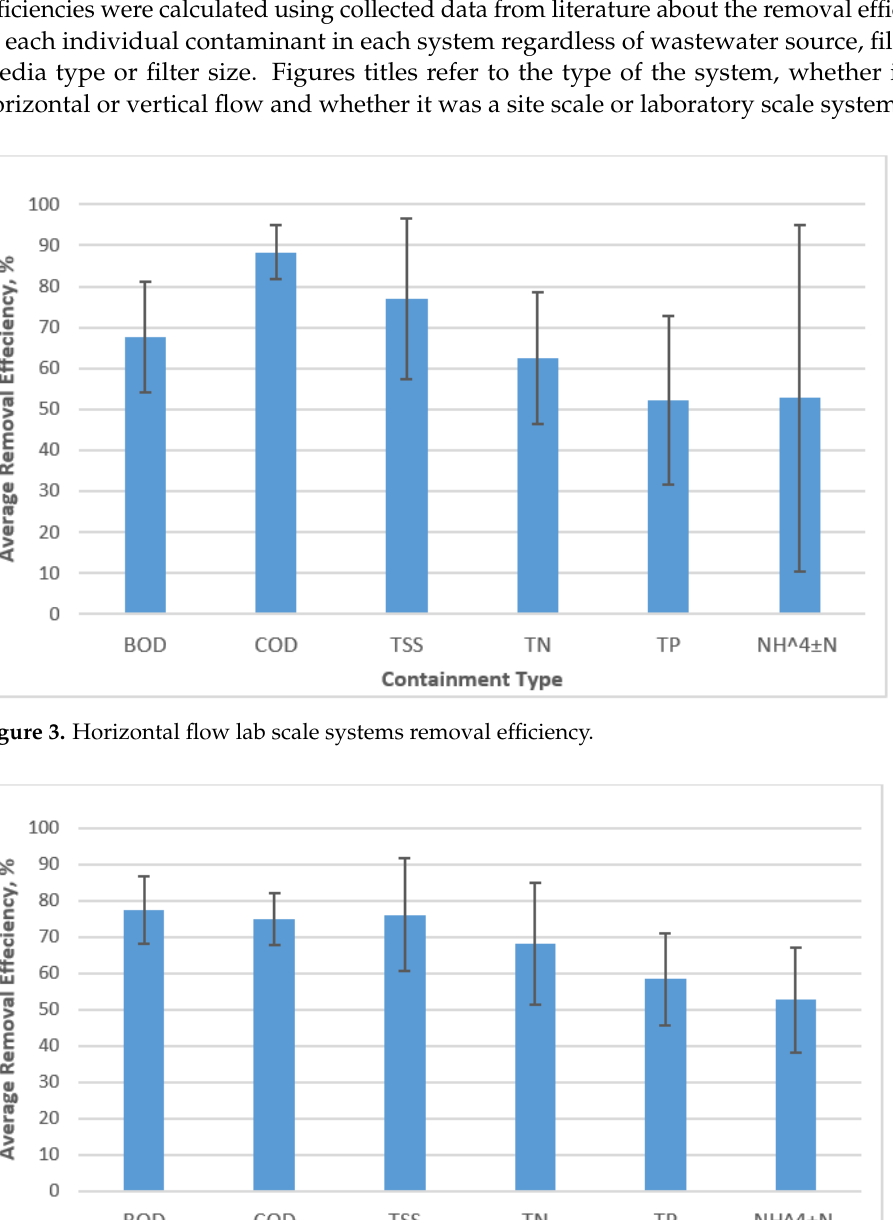
Figure 5. Vertical flow lab scale systems removal efficiency. Figure 6. Vertical flow site scale systems removal efficiency.